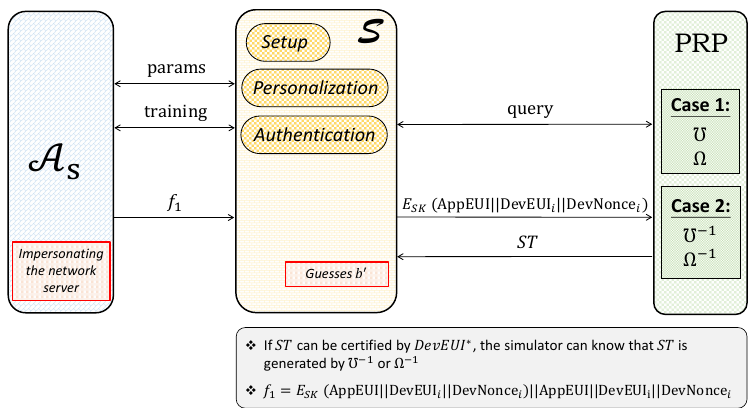
Figure 7. The game among A , who impersonates the network server; S ; and PRP oracles. Lemma 2. The suggested technique is secure against an attacker impersonating a legitimate end- device based on the IND-CCA security of the symmetric